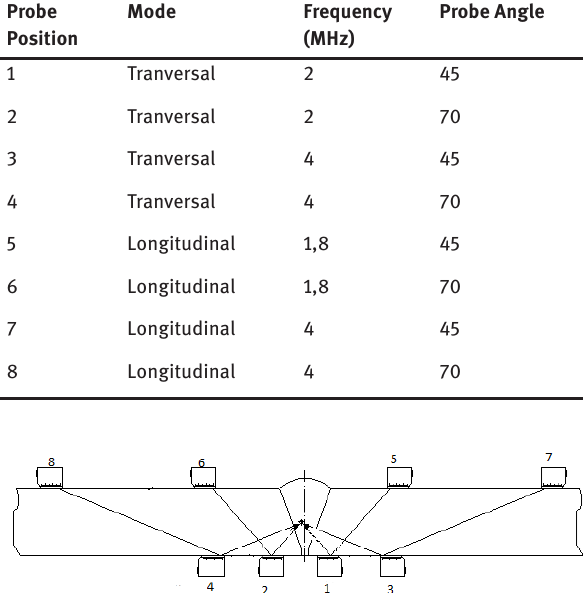
Table 2: The properties of the ultrasonic test probes.